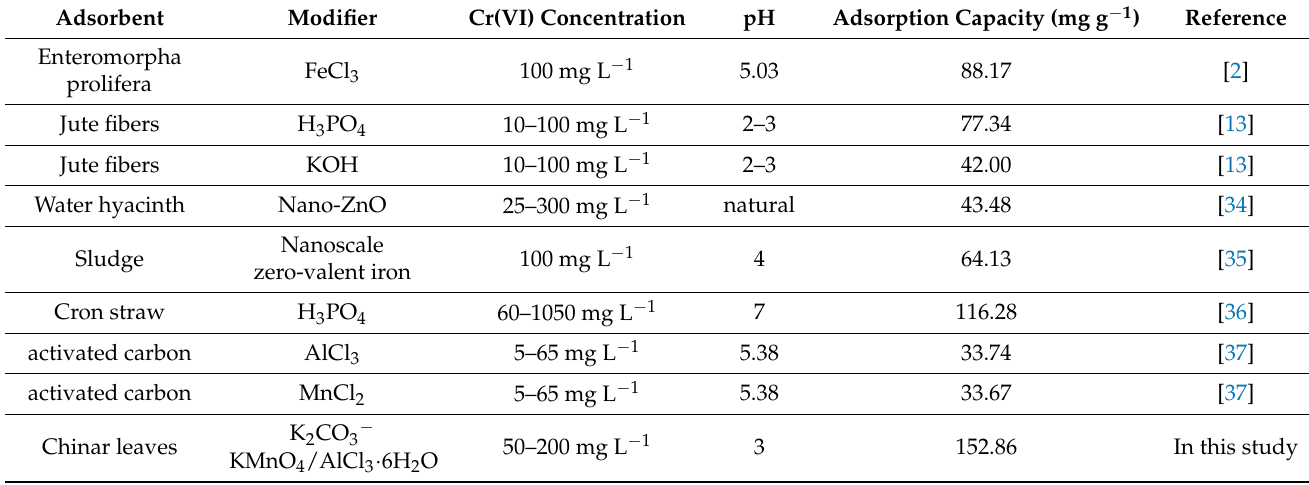
Table 2. Adsorption capacities of Cr(VI) by modified biochars derived from various